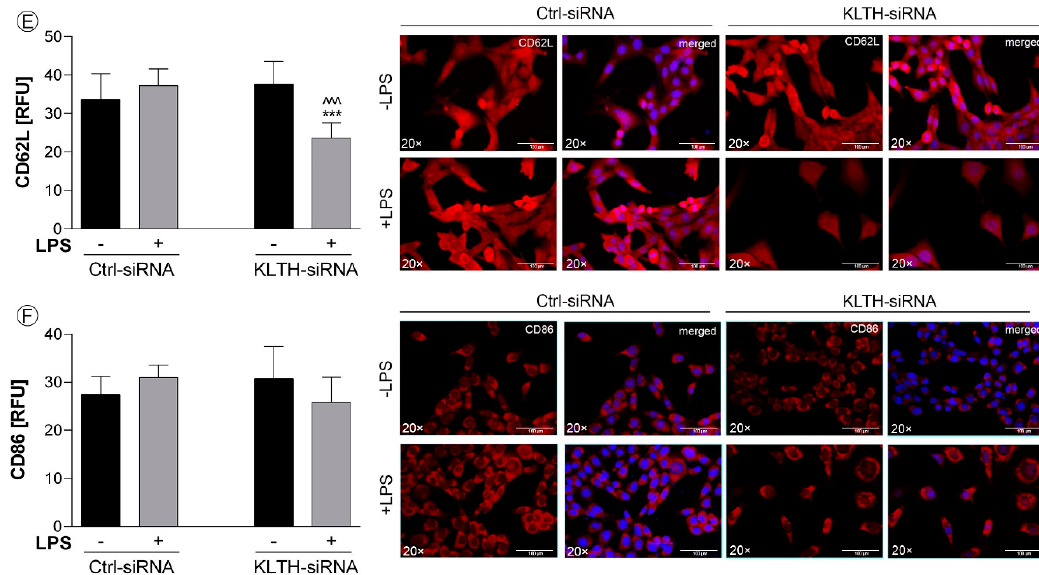
Figure 5. Klotho-depletion affects the inflammatory response in HT-22 hippocampal neuronal cells. The cells were transfected, treated for 48 h with LPS and then, the following parameters were controlled: ( A ) interleukins secretion; ( B – D ) expression of proteins CD62L and CD86; ( E ) surface expression of CD62L; ( F ) surface expression of CD86. Magnification of the objective lens ×20; scale bar, 100 µm. Bars indicate SD, n = 3, ***/^^^ p < 0.001, */^ p < 0.05, no indication/no statistical significance (one-way ANOVA and Dunnett’s a posteriori test). (*) indicate comparison between LPS-non-treated and treated Ctrl-siRNA or KLTH-siRNA cells, (^) indicate comparison between LPS-non treated Ctrl-siRNA and KLTH-siRNA cells or LPS-treated Ctrl-siRNA and KLTH-siRNA cells.